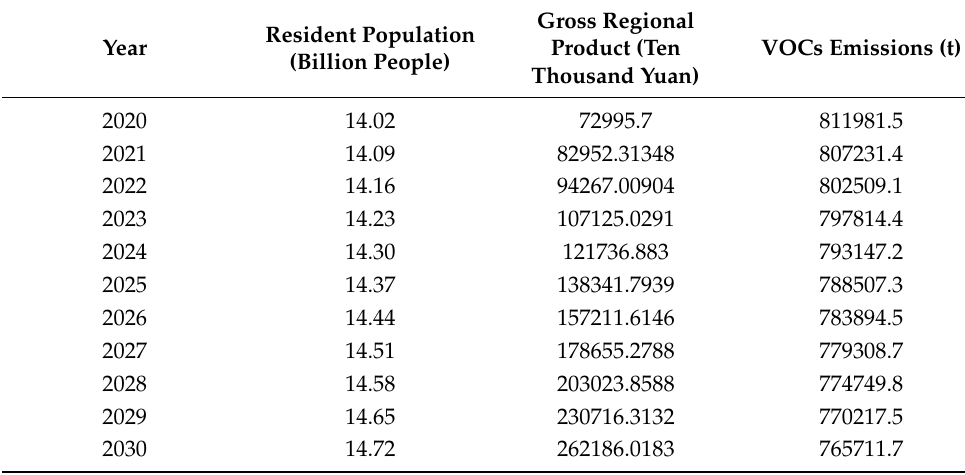
Table 5. Setting the number of permanent residents in China,